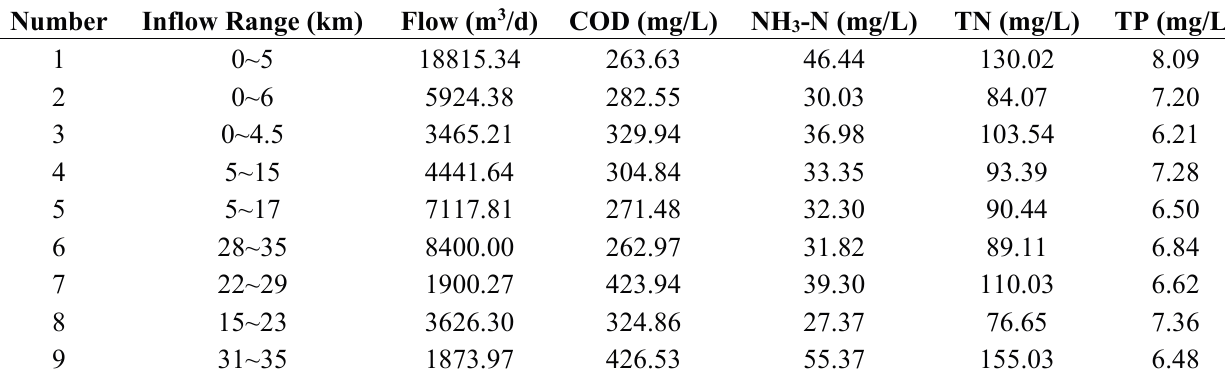
Table 5. Flow and concentrations of non-point sources.